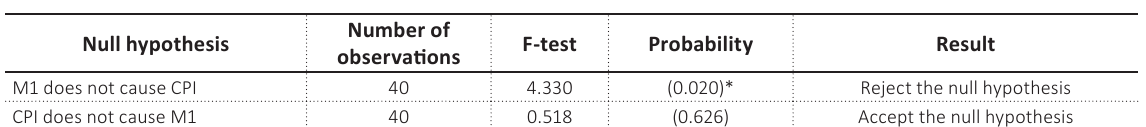
Table 5. Granger causality test